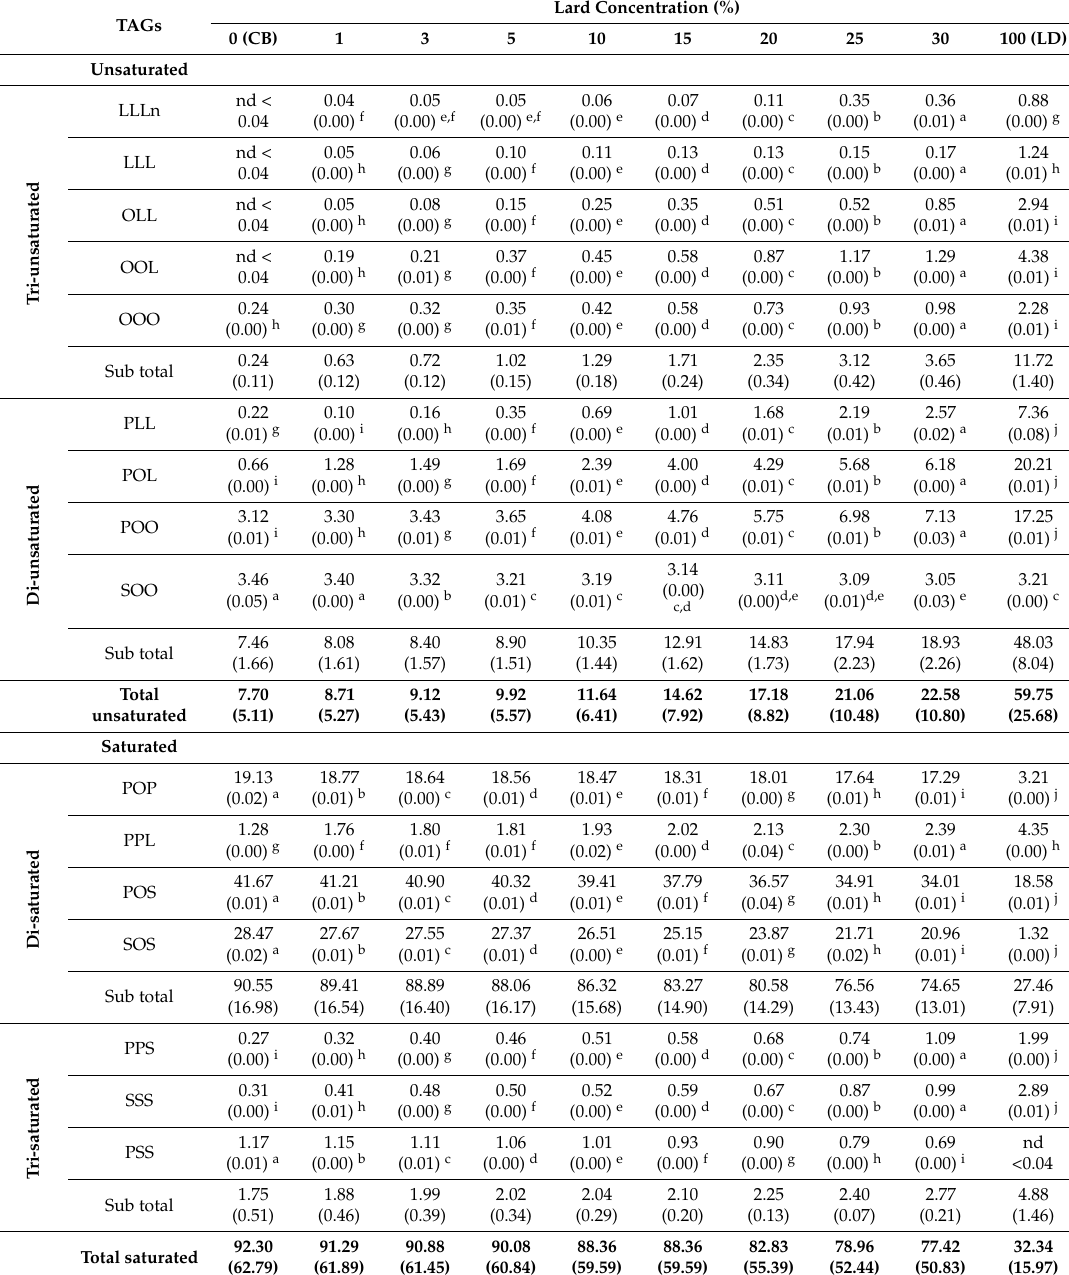
Table 2. TAG composition of lard, cocoa butter, and their